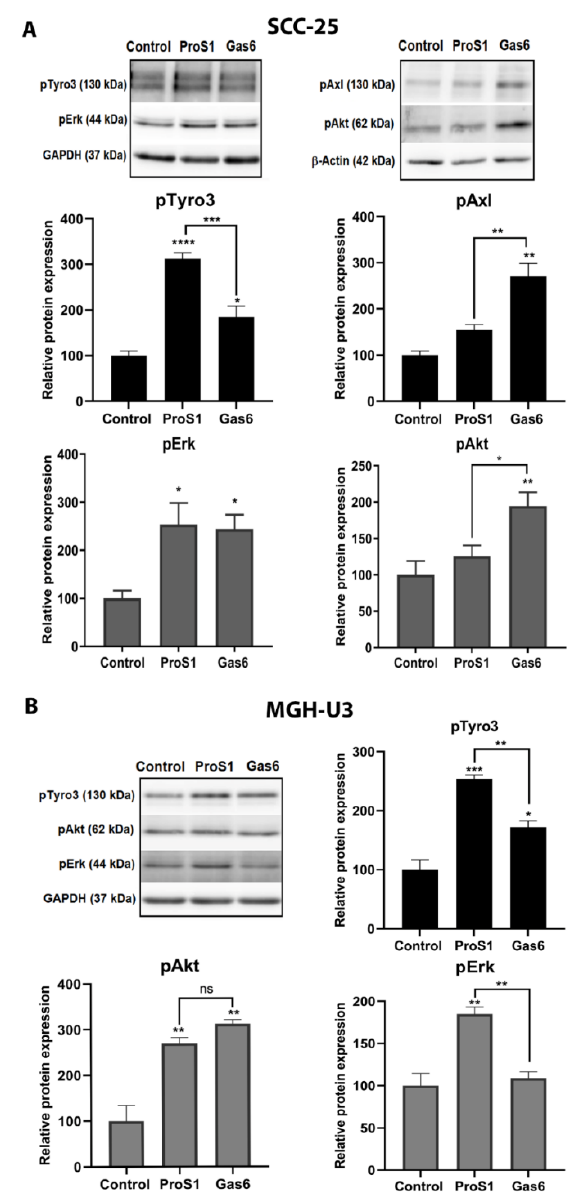
Figure 3. Role of TAM receptor expression profile in mediating the effects of ProS1 and Gas6 on RTK and intracellular signalling kinase phosphorylation. Experiments were conducted on cancer cell lines SCC-25 (express Tyro3 and Axl) and MGH-U3 cells (express Tyro3 only). Representative Western blot showing receptor activation and downstream signalling (Akt and Erk phosphorylation) by Gas6 and ProS1 in SCC-25 cells ( A ) and MGH-U3 cells ( B ) with accompanying graphs of densitometric quantification of bands. Data are mean ± SEM protein expression normalized against GAPDH as loading control protein; ANOVA with Tukey’s multiple comparison post-hoc analysis; **** p < 0.0001, *** p < 0.001, ** p < 0.01, * p < 0.05 and ns, not significant versus control or for comparisons indicated by lines (n = three or more separate